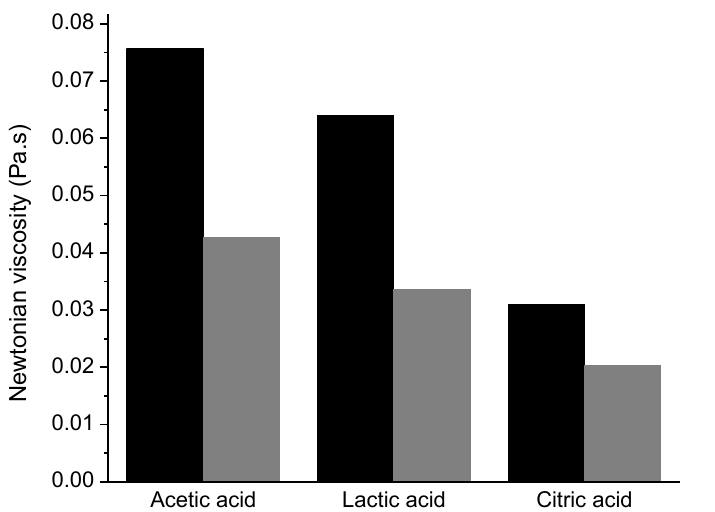
Figure 1. Newtonian viscosity of chitosan solutions (1.0% ( w / w )) dissolved using different acids (2 wt. %), at 5 °C (black) and 20 °C (gray).